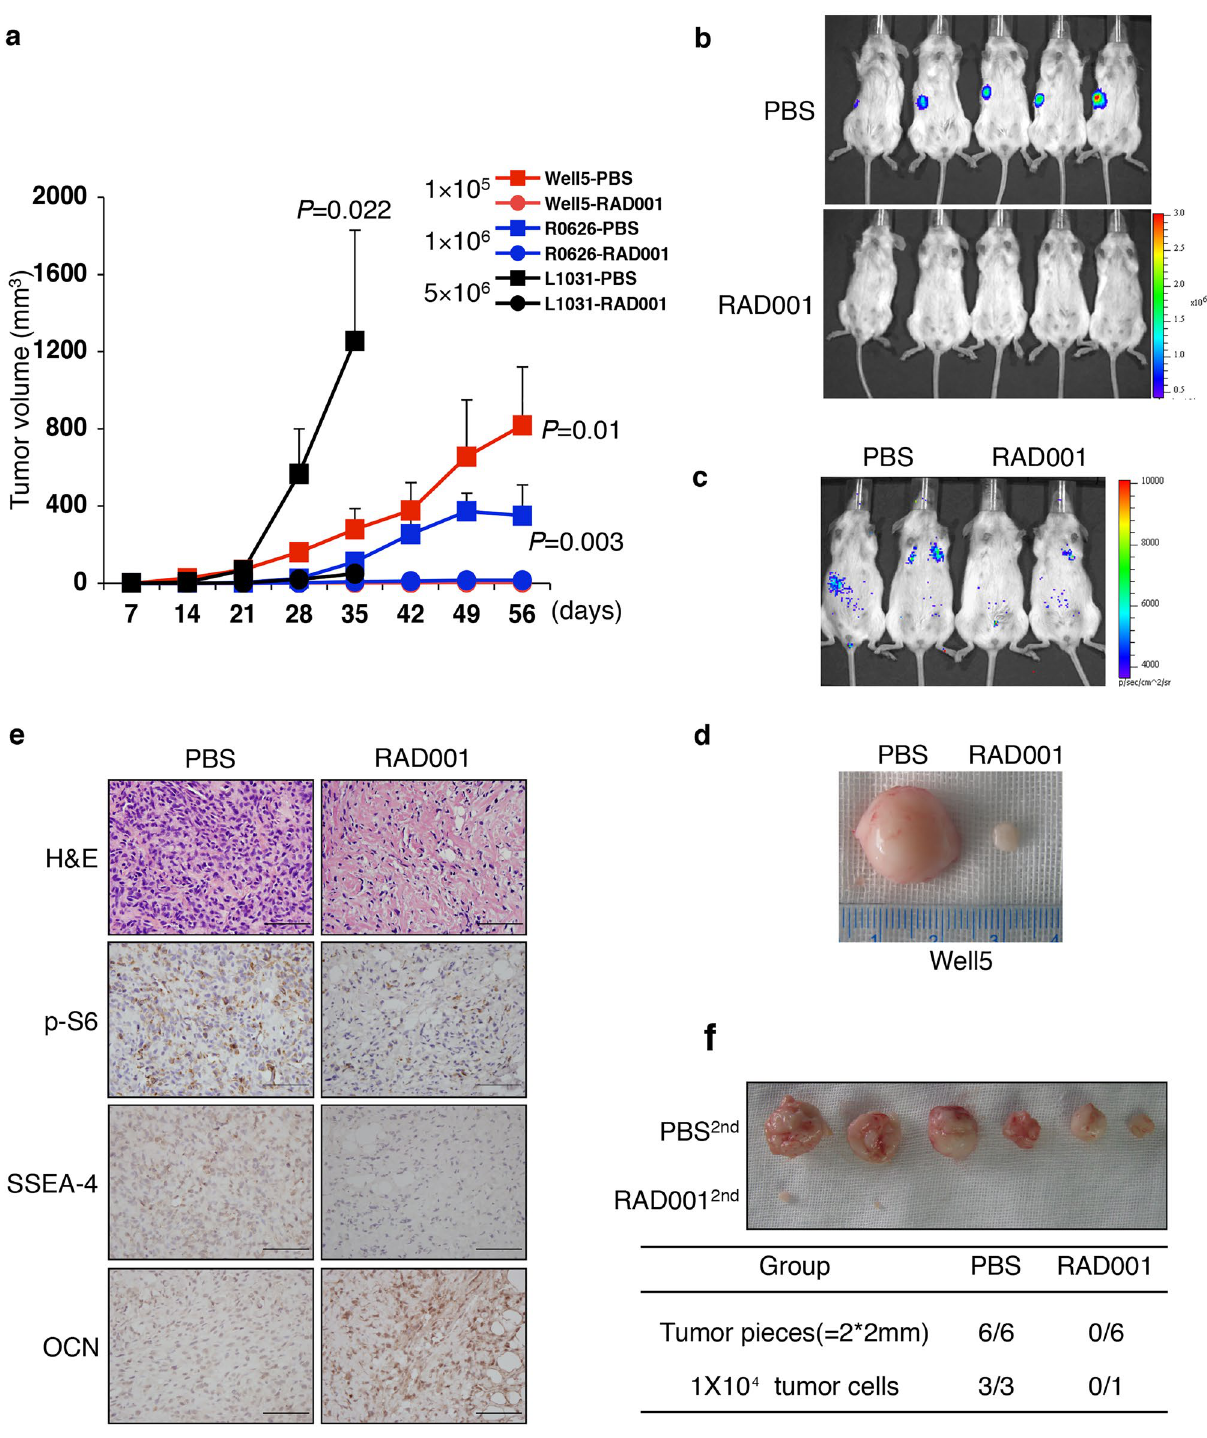
Figure 6. Terminal differentiation induction by mTOR-inactivation decreases SSEA-4 + TICs in vivo. ( a ) SSEA- 4 + cells (1–50 × 10 5 ) from the different resources as indicated were subcutaneously inoculated into NOD/SCID mice. The oral administration of PBS (filled box) or 5 mg/kg RAD001 (filled circle) commenced 2 days later. Tumor volumes are shown as the means ± SDs, n = 3–5. ( b , c ) Representative images of whole-body ( b ) or lung metastasis ( c ) bioluminescence 4 weeks following subcutaneous ( b ) or tail vein injection ( c ) of 1 × 10 5 PBS- or RAD001-treated SSEA-4 + Well5 cells (as in ( a )) into NOD/SCID mice. ( d ) Two representative tissue samples retrieved from the PBS-treated and RAD001-treated groups, respectively. ( e ) Immunohistochemical staining of p-S6, SSEA-4, or OCN in xenografts retrieved from the PBS-or RAD001-treated group, as in ( a , b ). Scale bars represent 100 μm. HE: hematoxylin–eosin. ( f ) Secondary tumorigenic xenograft formation of tumor tissue or cells after post-PBS or -RAD001 treatment, as in ( a , b ) (upper panel). Secondary tumorigenic xenografting rates (n/n) are summarized in the bottom table ( P <